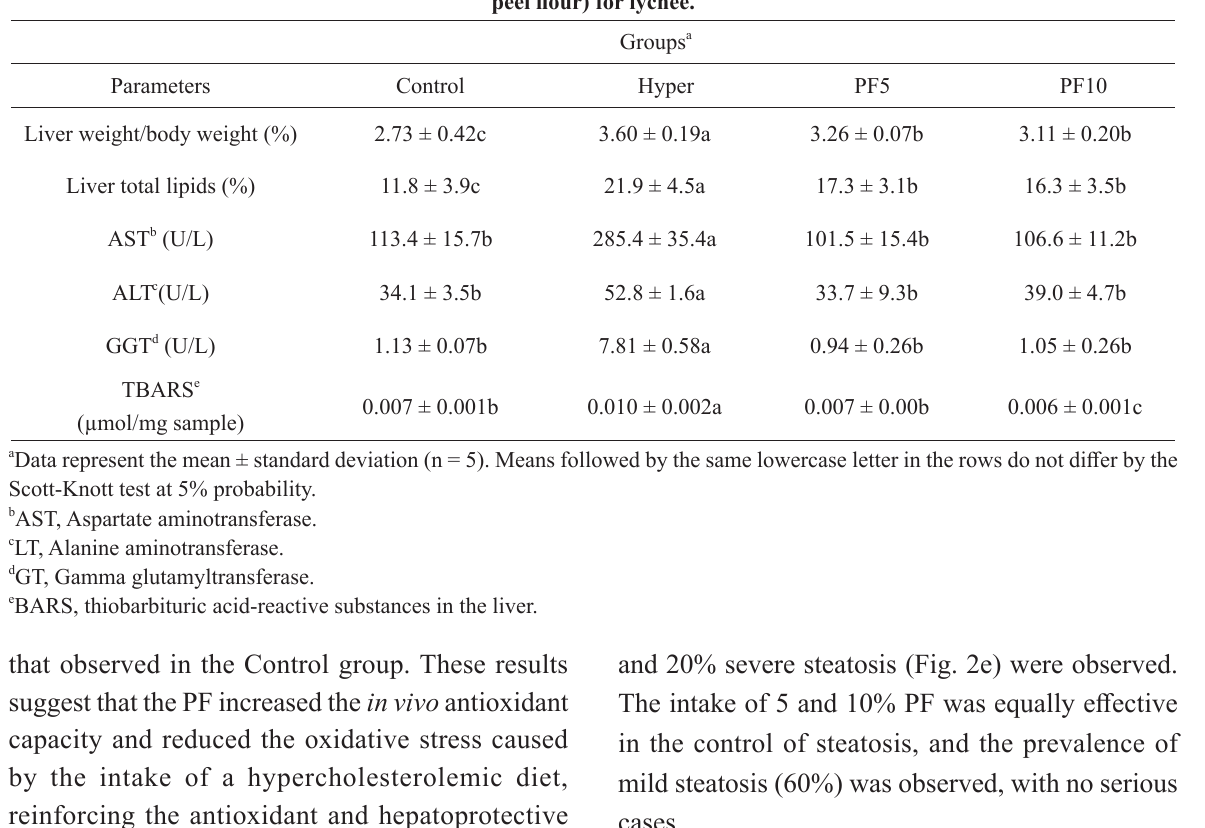
Markers of liver dysfunction and injury of animals in the groups: Control (standard diet AIN-93G), hyper (Hypercholesterolemic diet), PF5 (hypercholesterolemic diet + 5% peel flour) and PF10 (hypercholesterolemic diet + 10% peel flour) for lychee.